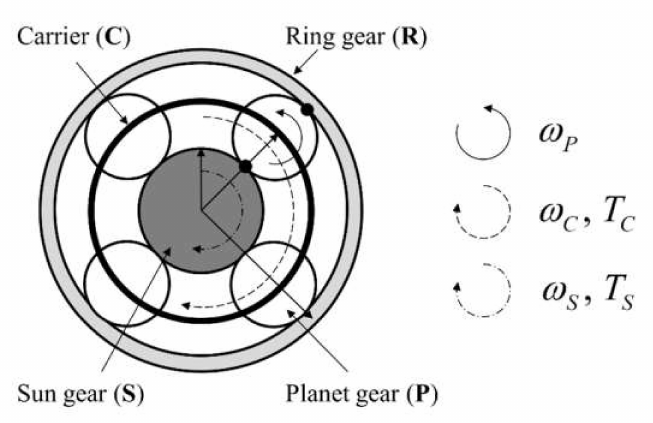
Figure 1. Schematics of a planetary gear-set and its components.